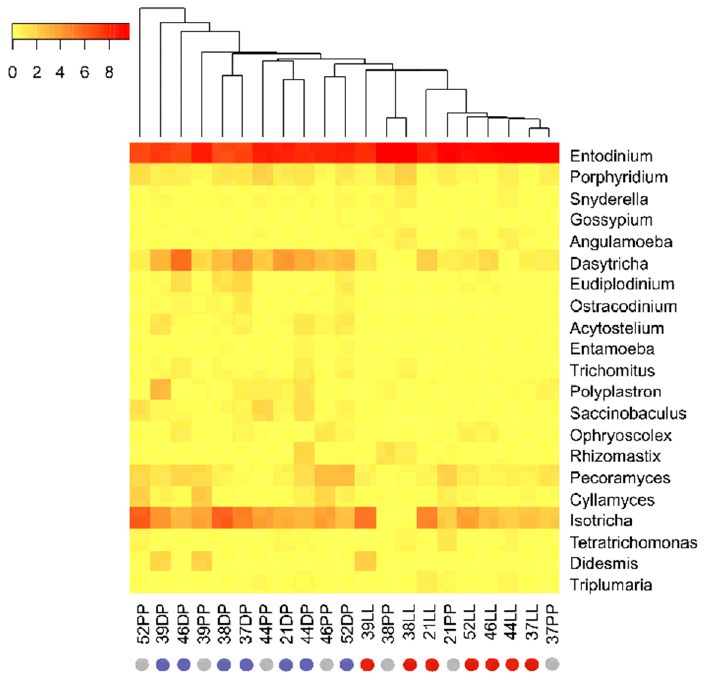
Figure 5. Heatmap at genus-level of active rumen eukaryotic communities of different physiological stages. The twenty most abundant genera (excluding the unclassified taxa) during LL, DP, and PP were included in the heatmap.